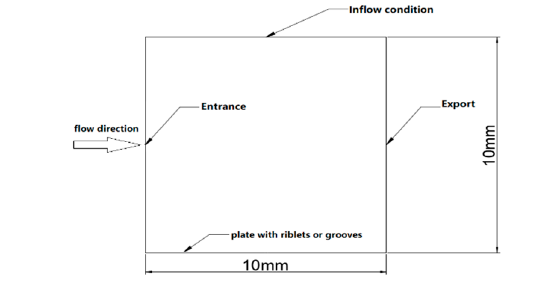
Figure 1. Calculation model.